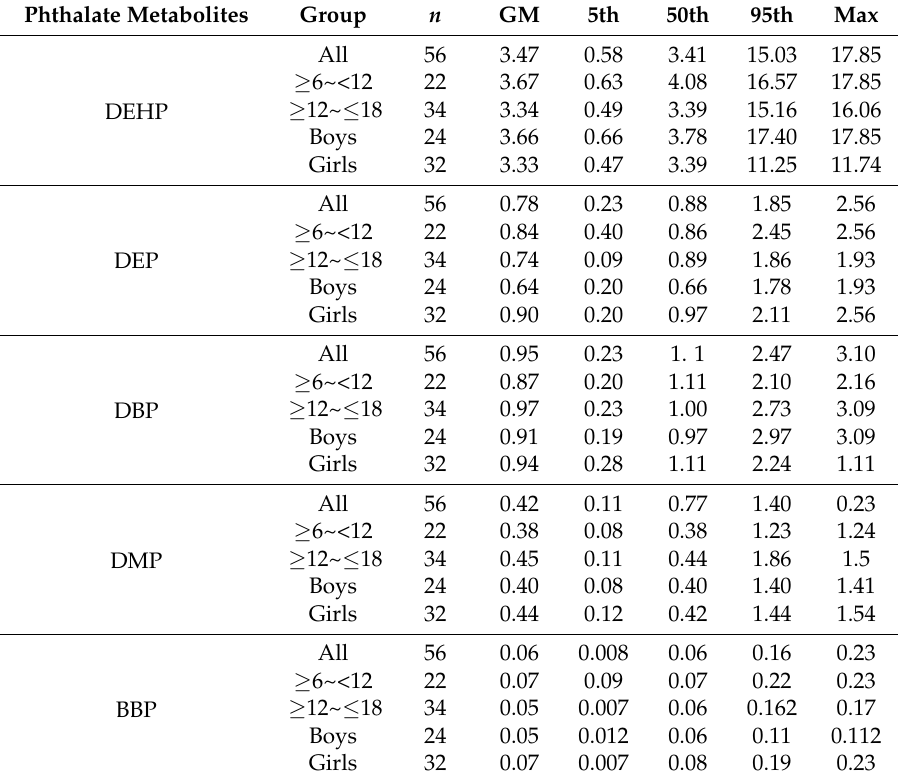
Table 5. Daily phthalate intakes ( µ g/kg body weight/day) estimated with the creatinine-based calculation model among the Iranian children and adolescents population ( n =